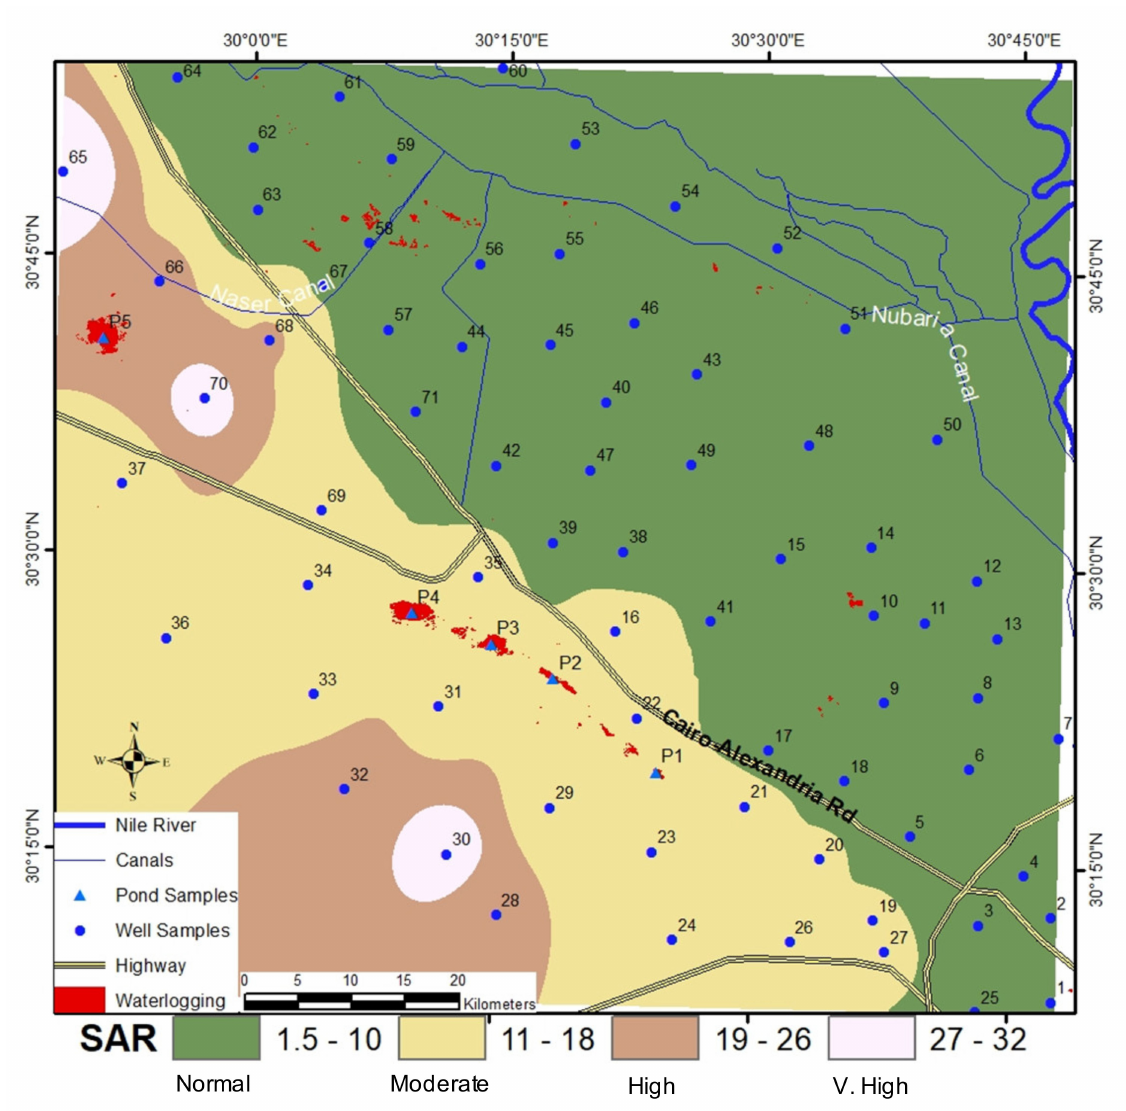
Figure 9. GIS IDW interpolation of sodium hazard based on the Wilcox classification of the sodium adsorption ratio